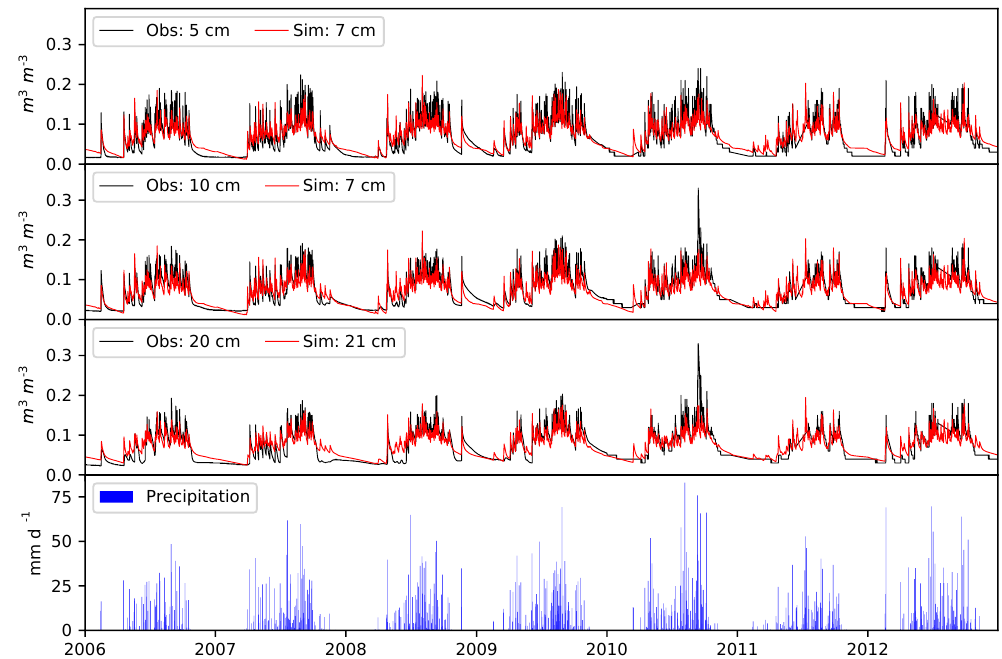
Figure 7. Observed and simulated soil moisture for the saprolite simulation at location P2.